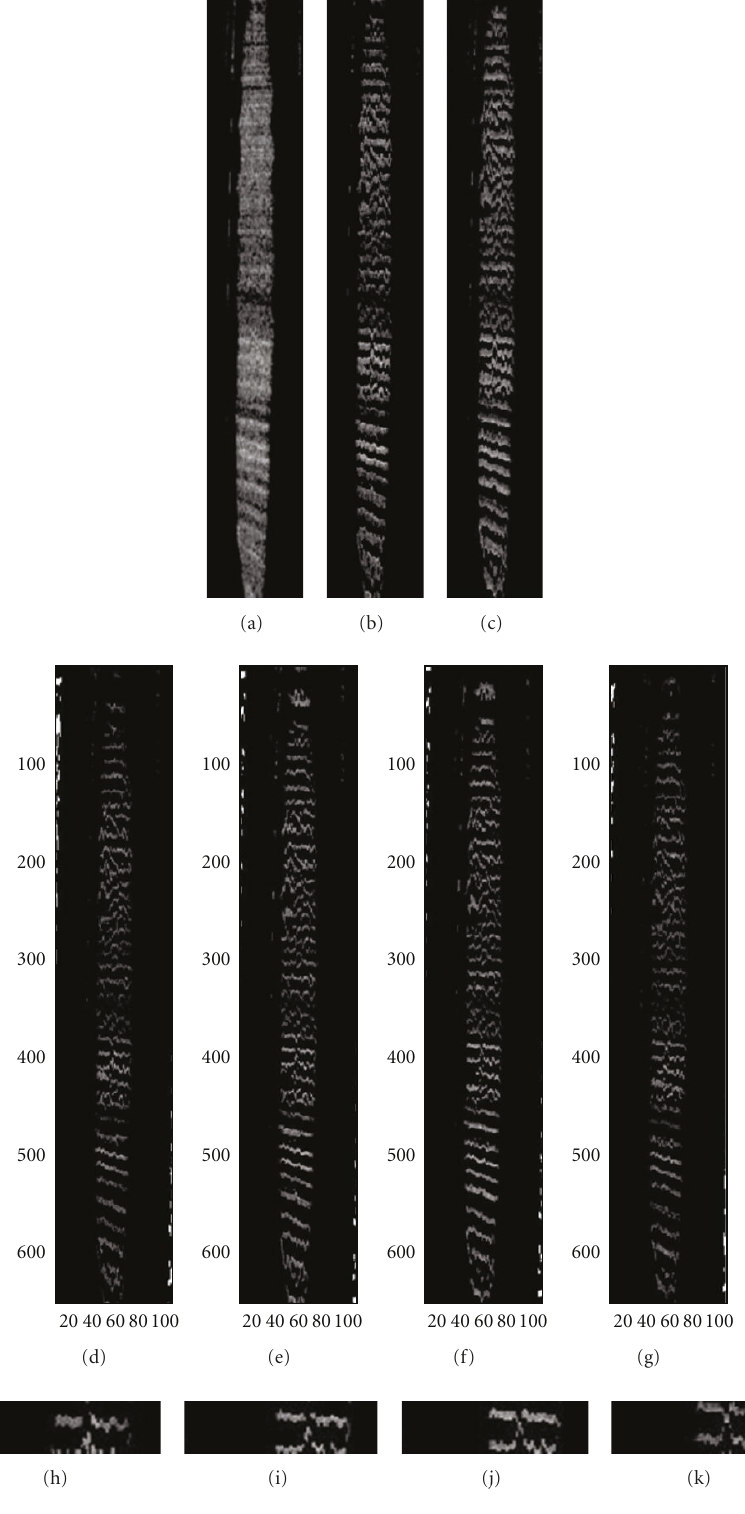
Figure 17: Tree growth estimates for populus sample (using variable frequency spacing filterbank): (a) original image, (b) first-half season, and (c) second-half season. Quarterly growth estimates: (d) 1st, (e) 2nd, (f) 3rd, and (g) 4th quarters. Magnified quarterly growth examples for 1 year: (h) 1st, (i) 2nd, (j) 3rd, and (k) 4th